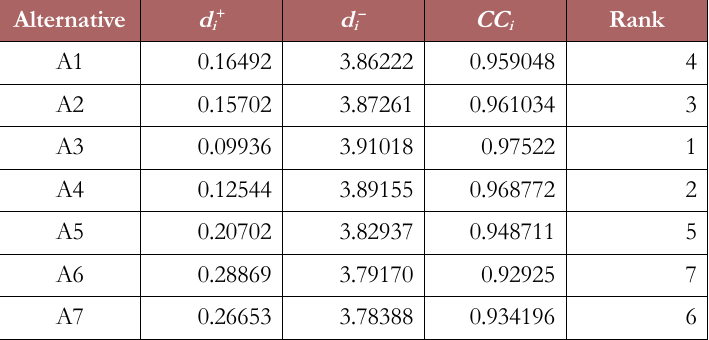
Table 12. Fuzzy TOPSIS